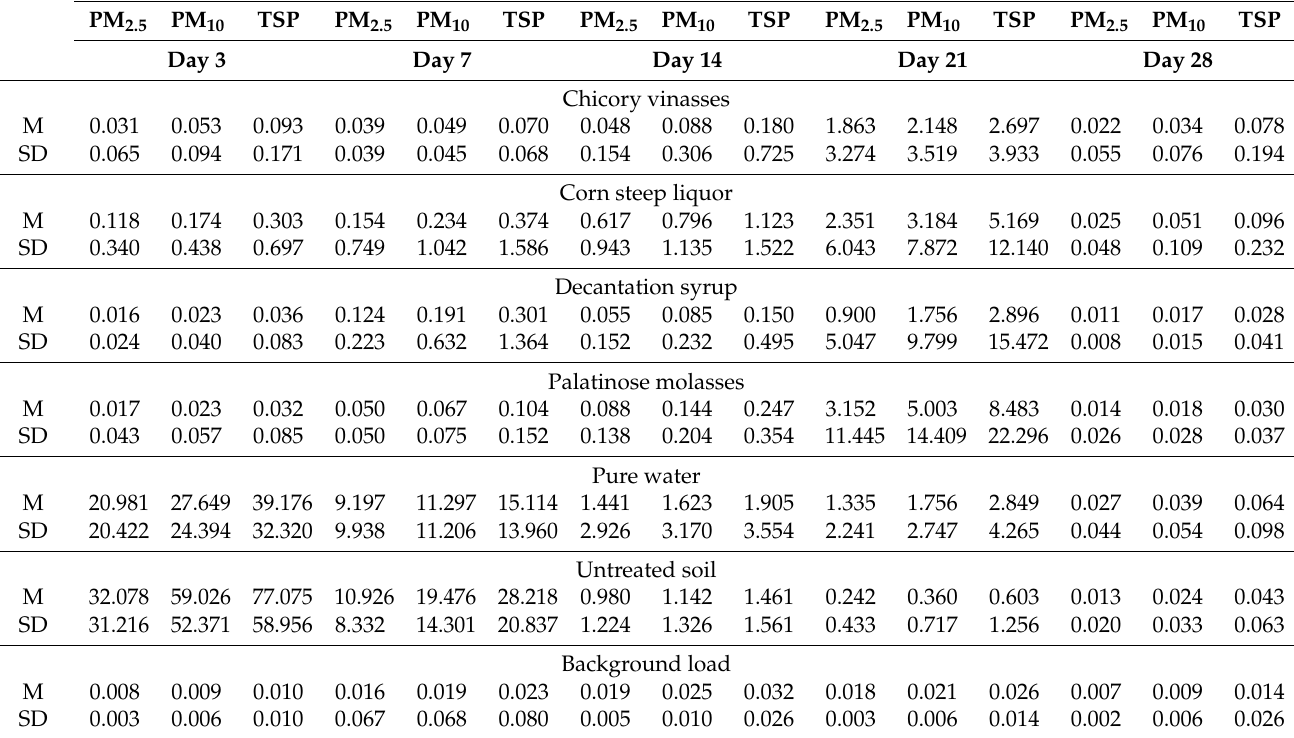
Table A4. Mean concentrations of dust particles (PM 2.5 , PM 10 , TSP) in air from mine soils treated with various food processing by-products. Dust emissions were measured 3, 7, 14, 21, and 28 days after application of dust